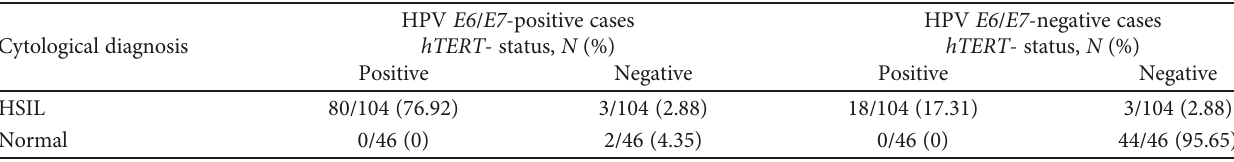
Table 3: RT-qPCR analysis of HPV E6/E7 and hTERT mRNA expression in HSIL versus normal clinical specimens. Cytological diagnosis